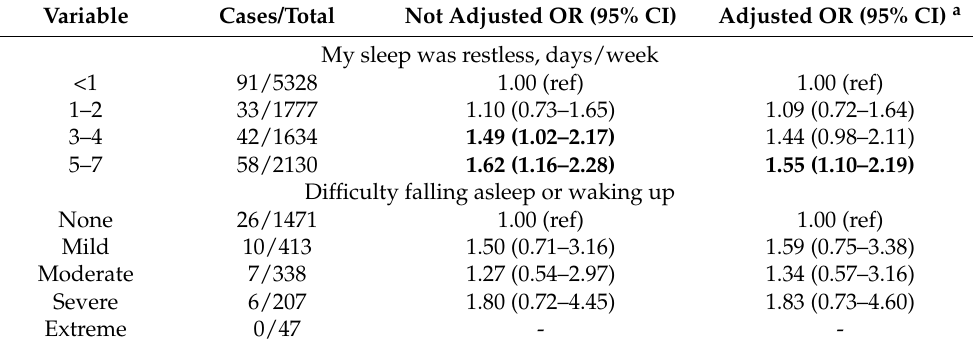
Figure 5. Joint effects of sleep duration and midday napping on hip fracture. Table 3. Association of sleep quality with hip